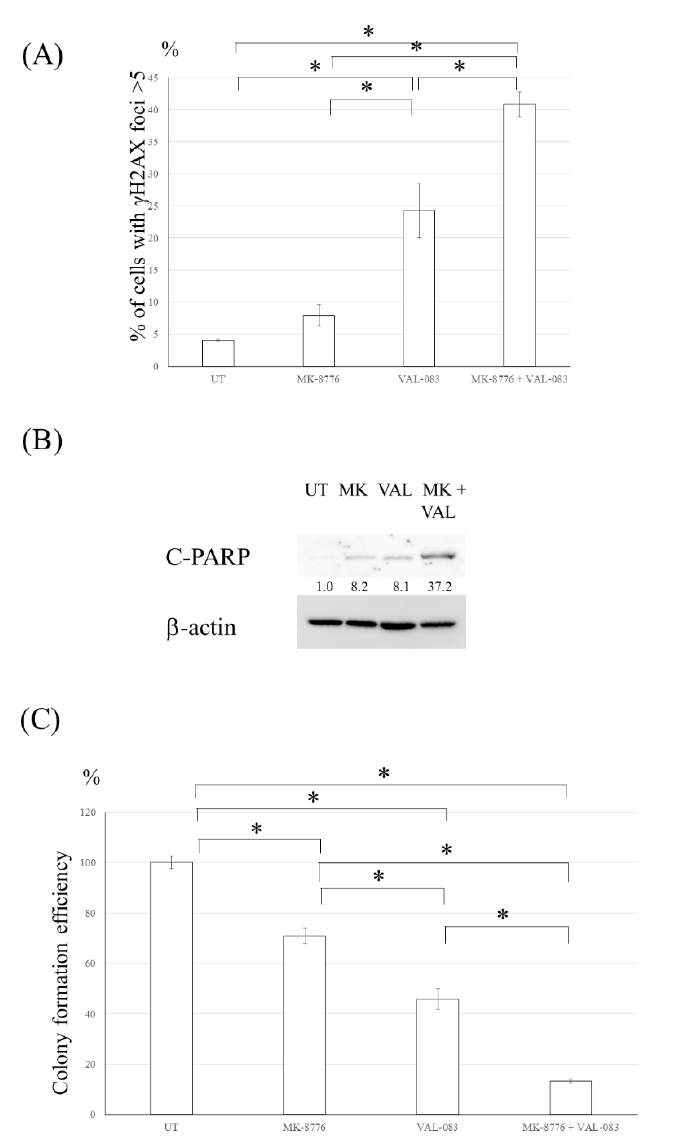
3.6. Chk1 Inhibitor Enhanced the Cytotoxicity Induced by DAG in TMZ-Resistant Glioma Cells Because the expression of p-chk1 was increased in the U251TMZR#8 clone treated with VAL-083 (Figure 5D), the effect of a chk1 inhibitor on the VAL-08-induced cytotoxicity was evaluated. A chk1 inhibitor, MK-8776, increased γ -H2AX foci and induced apoptosis in the U251TMZR#8 clone treated with VAL-083 (Figure 6A,B). A colony formation assay revealed that MK-8776 enhanced the cytotoxicity effect of VAL-083 on the U251TMZR#8 clone (Figure 6C).